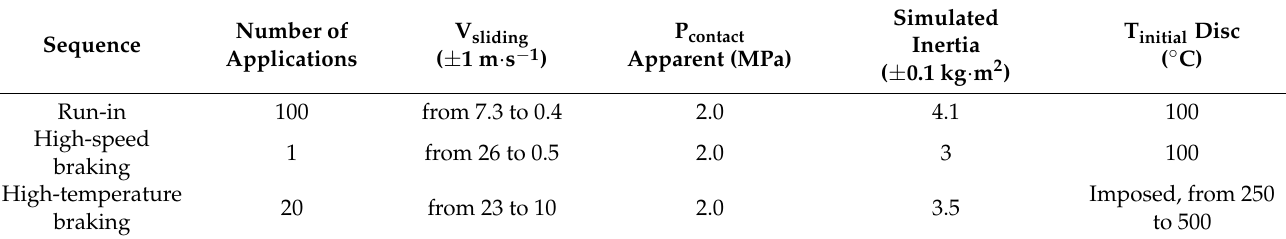
Table 3. Braking test program at a reduced scale.